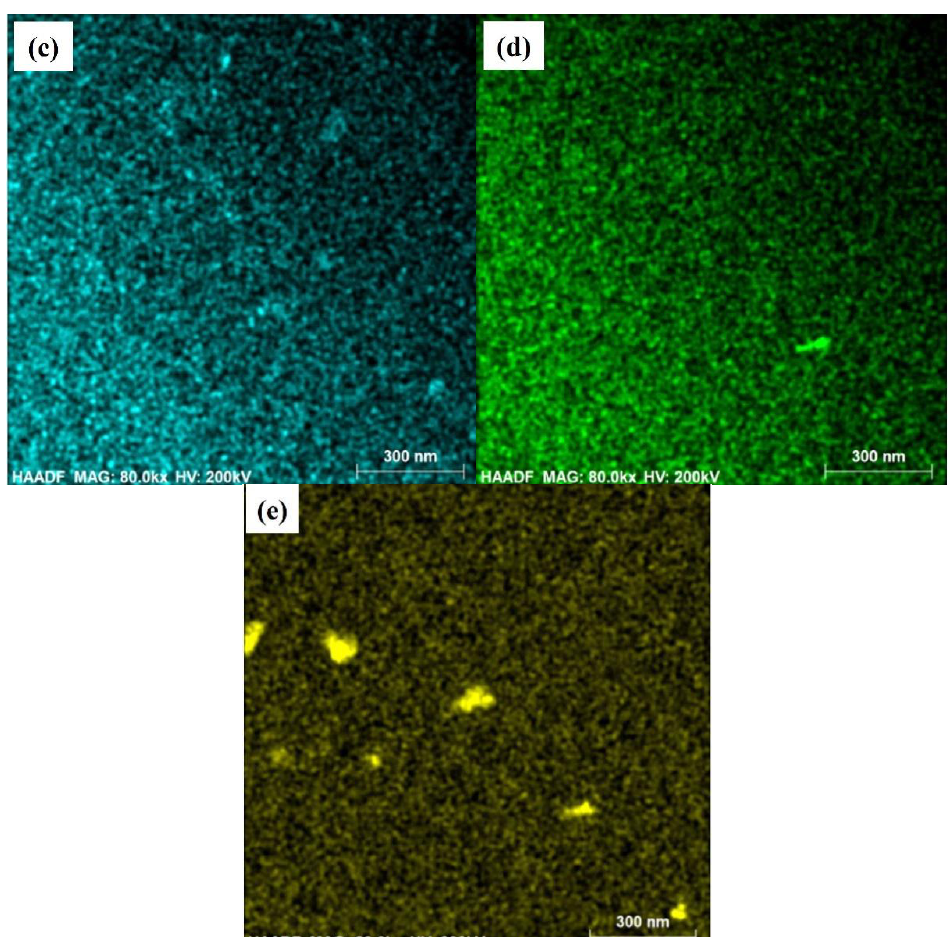
Figure 14. Energy dispersive X-ray spectrometer (EDX) analysis of nano-sized Al 2 O 3 on microstructure of rheoformed 2024 aluminum matrix composite component reinforced by 5 vol % Al 2 O 3 nanoparticles at 615 °C for for 25 min stirring time ( a ) TEM micrograph; ( b ) Al; ( c ) Cu; ( d ) Mg; ( e ) O. As indicated in Figure 14, uniform dispersion of Al 2 O 3 nanoparticles was noted in the TEM